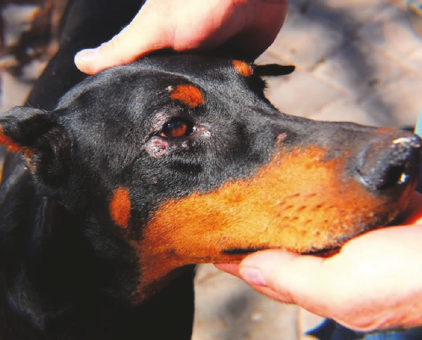
Figure 1: Inflammation in and about the eye in a Doberman treated with G6PD inhibition for a cytologically verified soft tissue sarcoma in her right ischium. Inflammation such as this is a feature of the human autosomal recessive disease mevalonate kinase deficiency, caused by NALP3 inflammasome-mediated IL1 𝛽 secretion